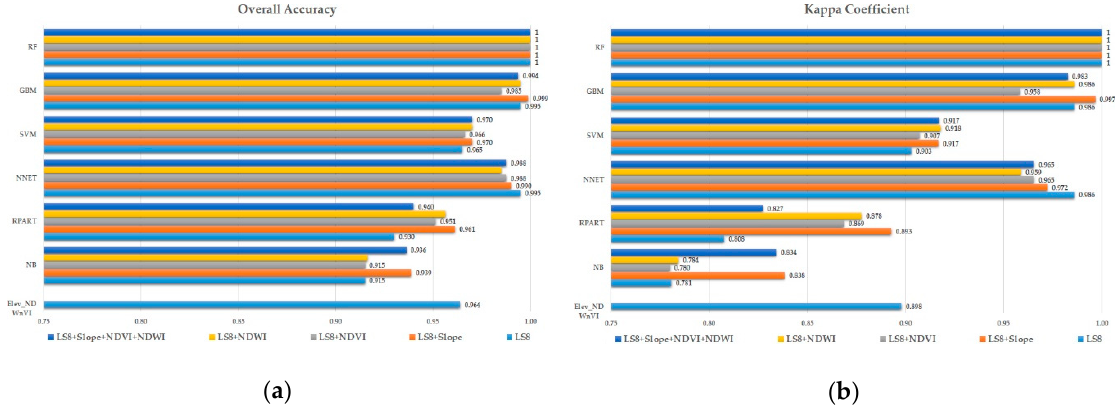
Figure 5. ( a ) Overall accuracy (OA) and ( b ) Kappa coefficient (Kappa) of all the algorithms for provided multiband data.